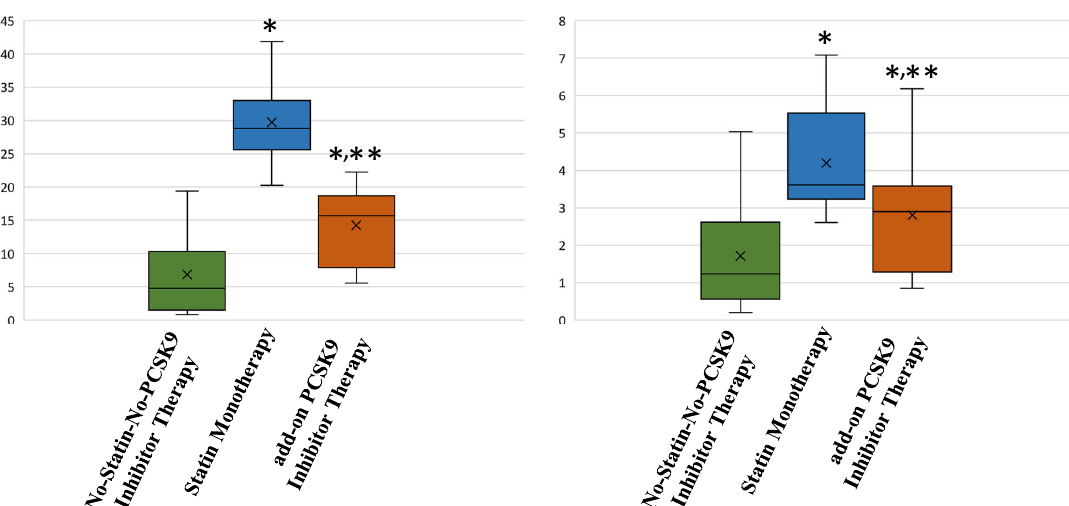
Fig. 3 a , b : Comparison of annual percentage change in coronary artery calcium score (CAC) between no-statin-no-PCSK9 inhibitor therapy ( n = 10), statin monotherapy ( n = 15), and add-on PCSK9 inhibitor therapy in the paired longitudinal study ( n = 16). Data were expressed as the median and 10th – 90th percentiles. The horizontal line inside the box is the median. Boxes represent the interquartile range (25th – 75th percentile). Whiskers represent the 10th – 90th percentile. The x marks in the box indicate the average. a linearized CAC score progression, b log-transformed CAC score progression. * P < 0.05 vs. no-statin-no-PCSK9 inhibitor therapy and ** P < 0.05 vs. statin monotherapy by the non- parametric Mann – Whitney U